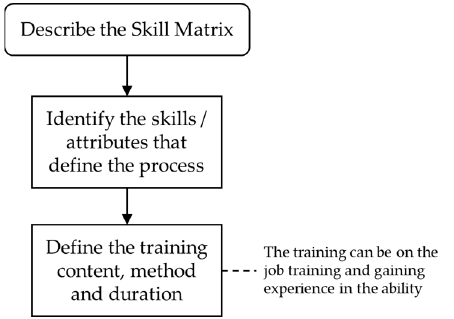
Figure 5. Skill matrix definition. [Source: inspired by the chapter “Skill management” (pages 113–119) in reference [12]].